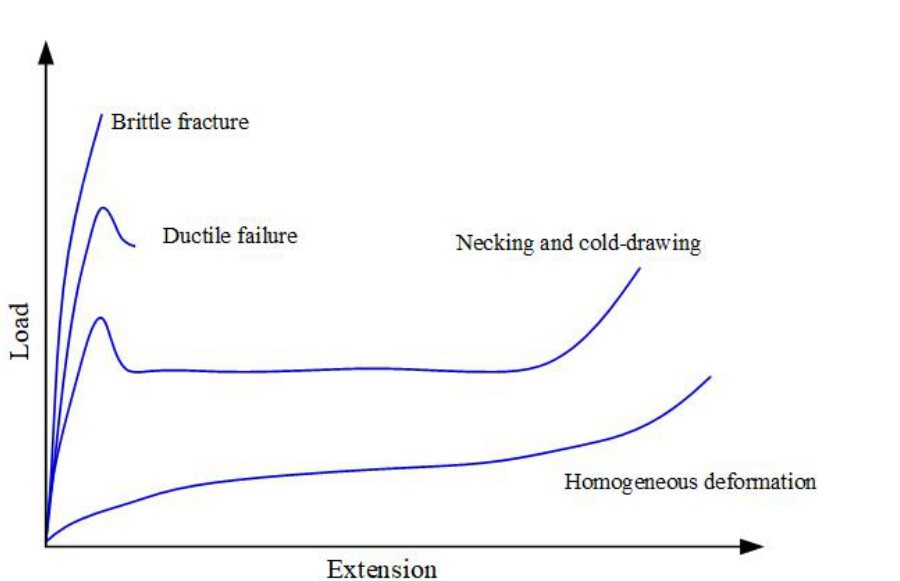
Figure 12. Load-extension curves for a typical polymer tested at four temperatures, showing different regions of mechanical behavior: brittle fracture; ductile failure; necking and cold-drawing and homogeneous deformation (quasi-rubber-like